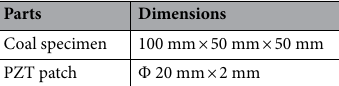
Table 1. The parts dimensions of the